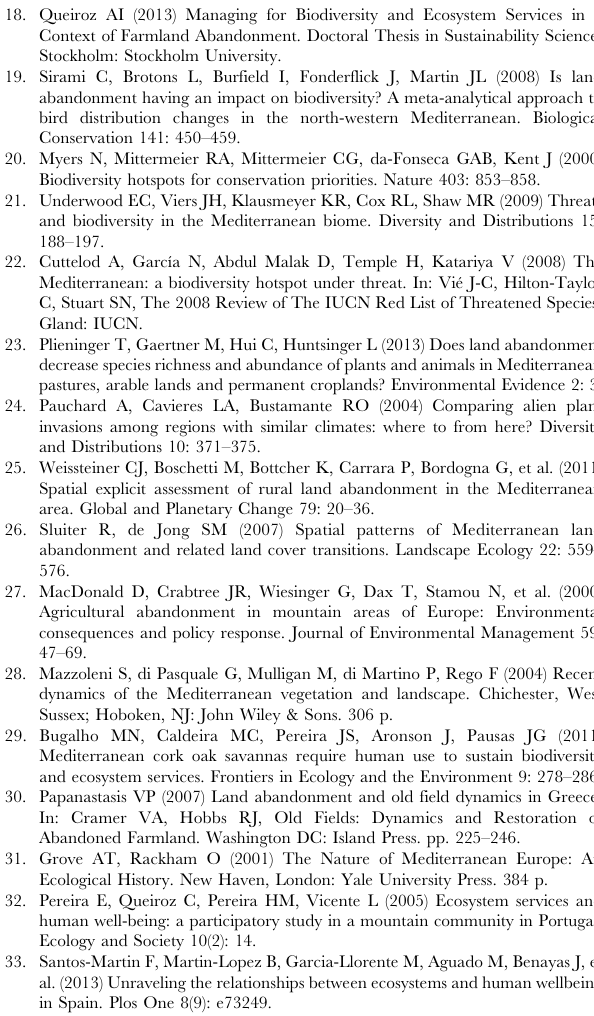
Table S5 Summary of additional variables included in the meta-